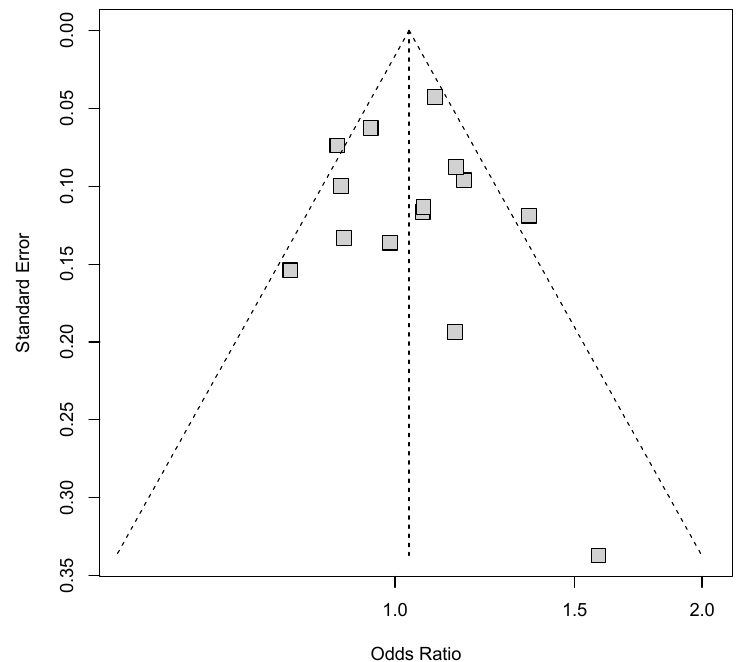
Figure 4. Funnel plot for publication bias under the allele model. Each gray square represents one single study involved in this meta-analysis.